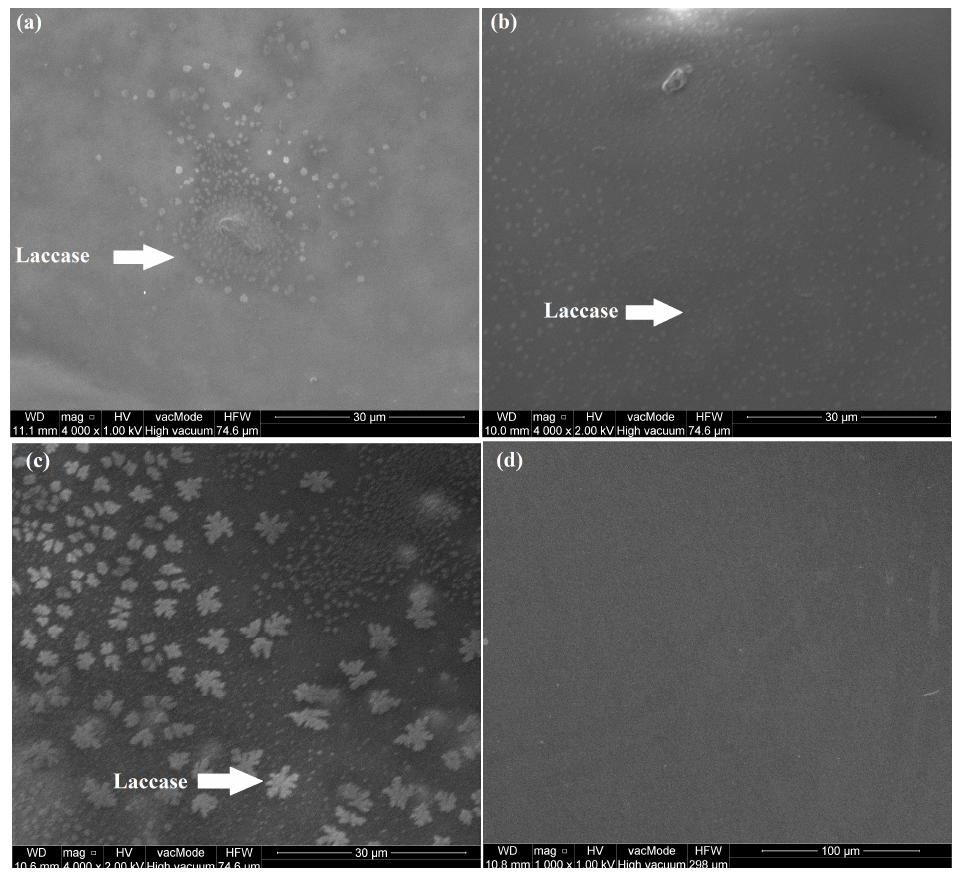
Figure 1. Scanning electron microscope (SEM) images of laccase layers deposited for ( a ) 10 s, ( b ) 15 s, ( c ) 30 s by corona soft plasma polymerization (SPP) deposition process and ( d ) unmodified glassy carbon electrode (GCE).